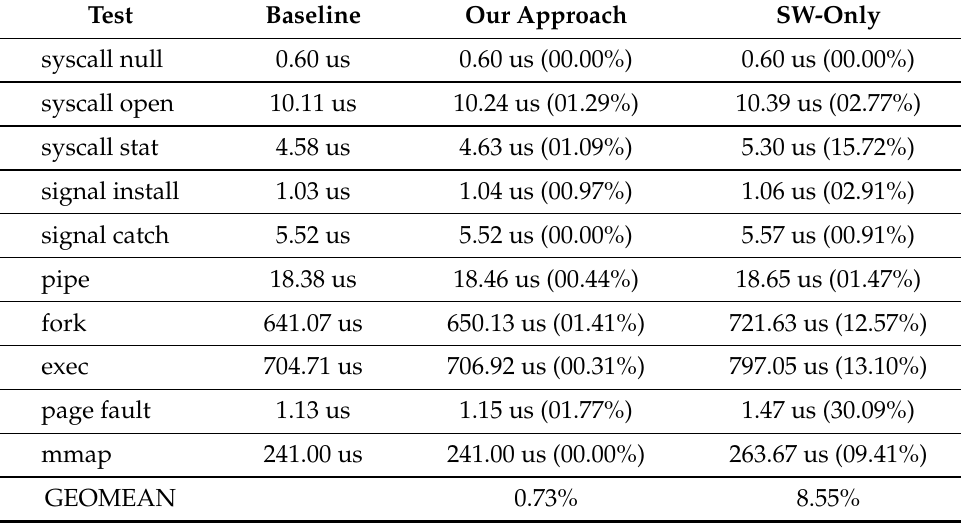
Table 3. Performance overhead for kernel operations.